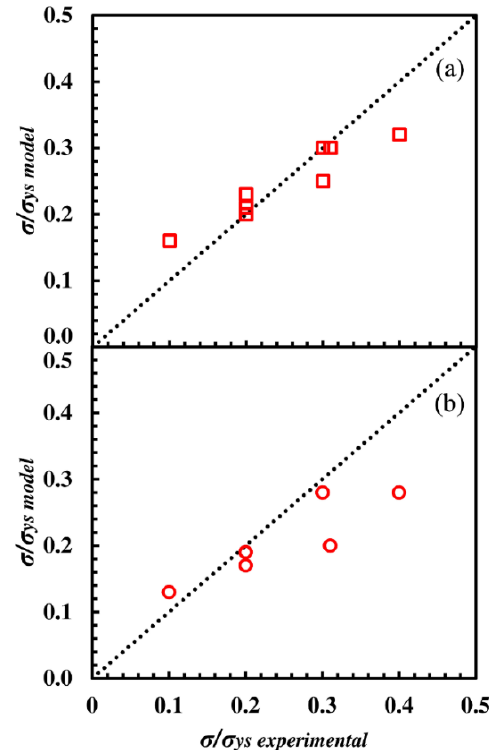
Figure 12. Relative Young’s modulus E / E s of NP Au foams as a function of relative density  . Experimental data (•) are taken from Table 2 of Reference [7]. Model predictions: part ( a ) shows the case of ligaments with square (□) cross-section and part ( b ) shows the case of ligaments with circular (○) cross-section.